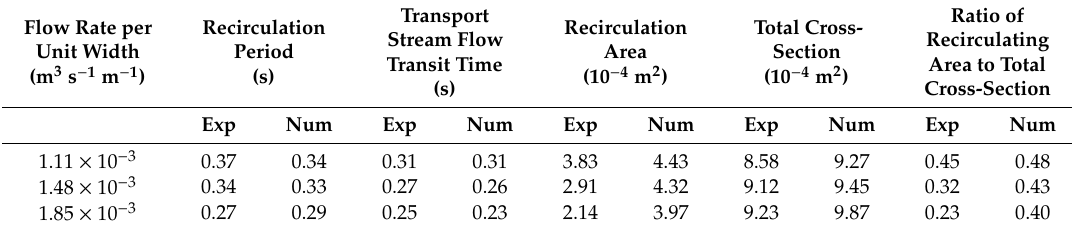
Table 1. Comparisons of experimentally determined and numerically simulated hydraulic features of potential photobiologic significance for the 6° channel slope.